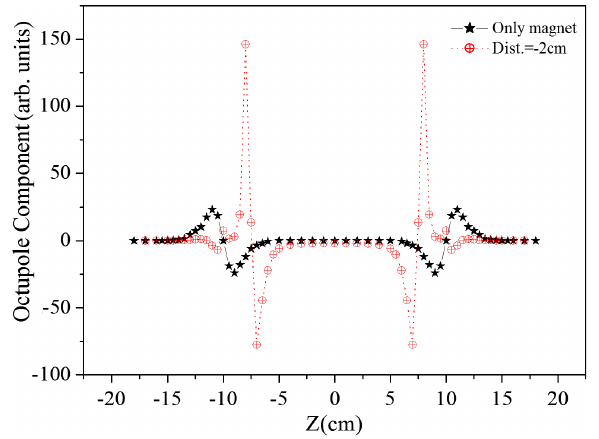
FIG. 15. Variation of the octupole component in arbitrary units along the length of the magnet in the case of a magnet without end tubes and when two end tubes are placed at − 2 cm from the edge of the